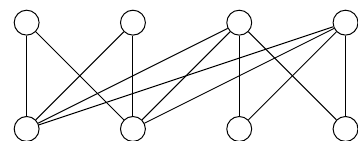
Figure 6. A biconnected bipartite permutation graph having no Hamiltonian